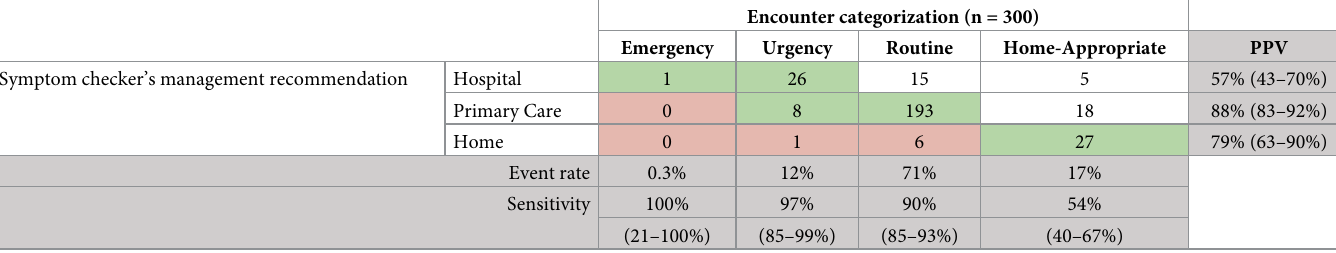
Table 3. Triage recommendations made by the prototype symptom checker for patients self-presenting to family physician clinics.